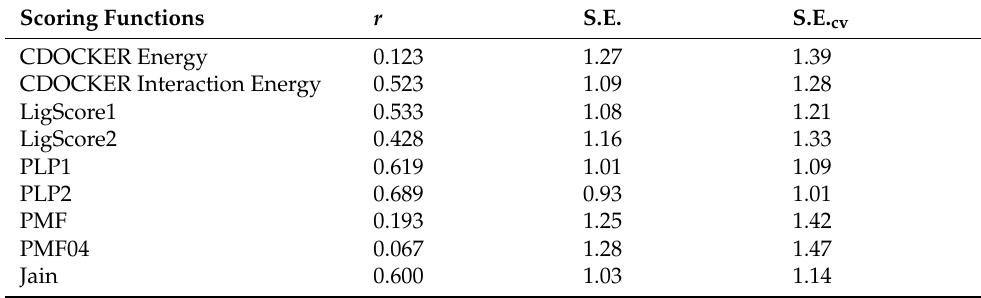
Figure 3. Dependence of pIn on the 3 χ v index for 20 molecules from the Protein Data Bank. Com- pounds and their PDB IDs are listed in Table S1. Table 2. Statistical parameters of the single QSAR models using scoring functions for the set of 20 molecules from the Protein Data Bank.